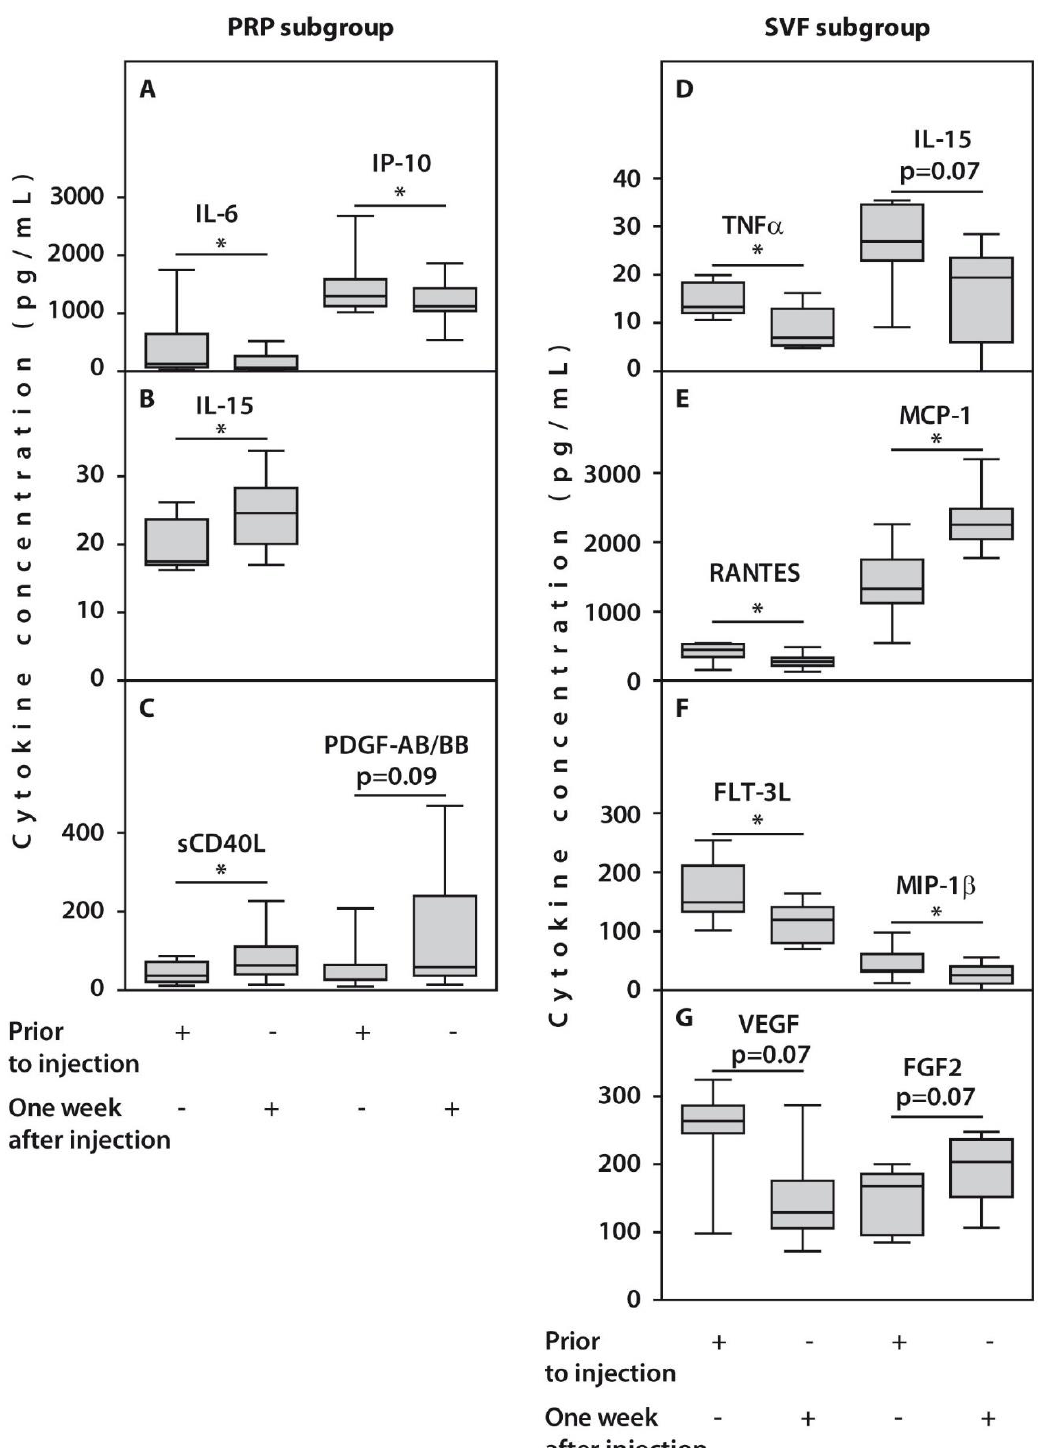
Figure 4. Synovial cytokine concentrations in patients with OA subjected to HTO therapy with post- surgery injections of PRP ( A – C ) or SVF ( D – G ) prior to the injection or one week after injection. All statistically significant differences are indicated with an asterisk (*). Abbreviations: IL-6, interleukin 6; IP-10, interferon-gamma inducible protein-10; IL-15, interleukin 15; sCD40L, Soluble CD40 ligand; TNFα, tumor necrosis factor alpha; RANTES, Regulated upon Activation, Normal T Cell Expressed and Presumably Secreted; MCP-1, monocyte chemoattractant protein-1; FLT-3L, FMS-like tyrosine kinase 3 ligand; VEGF, vascular endothelial growth factor; FGF2, fibroblast growth factor 2.